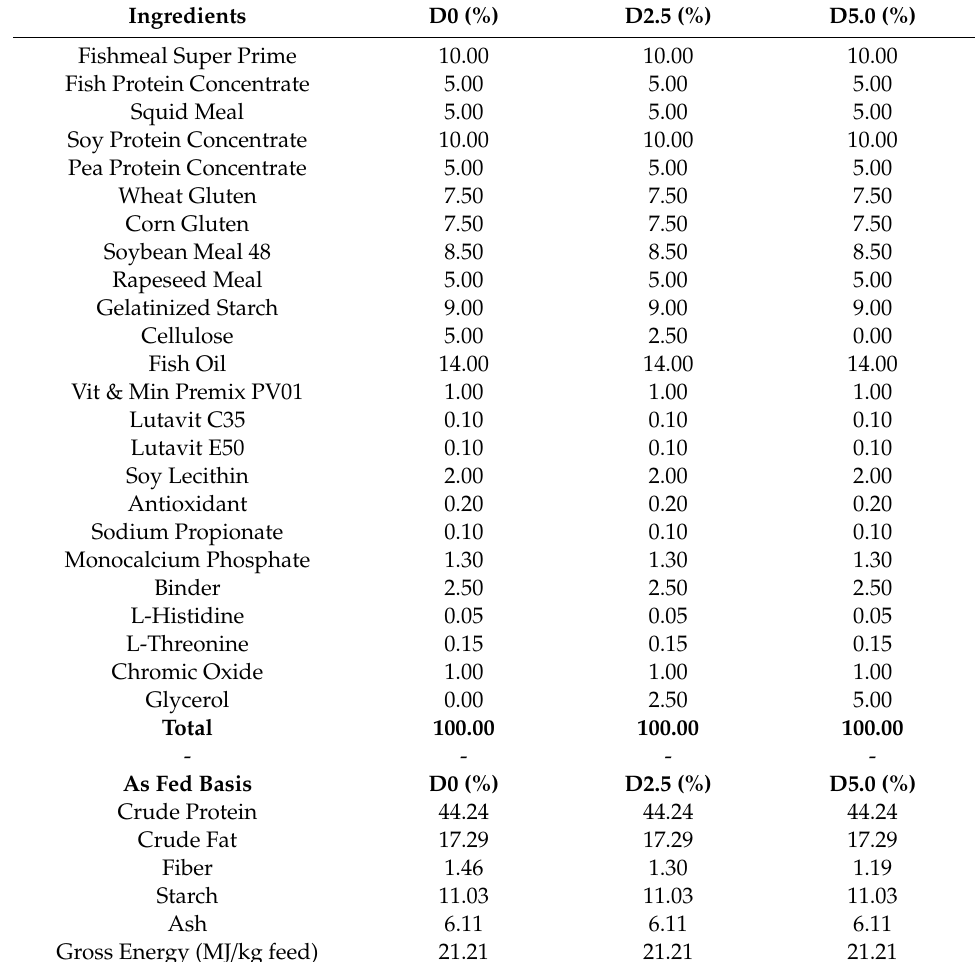
Table 2. Diets ingredients list and composition as fed basis. Key: D0—control diet, D2.5—diet